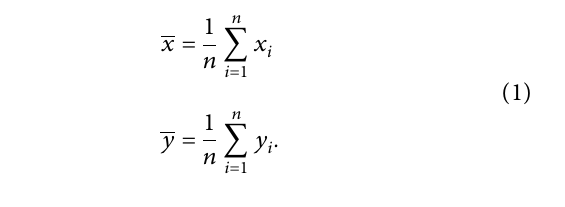
Table 2: Relationship between correlation coefficient | r